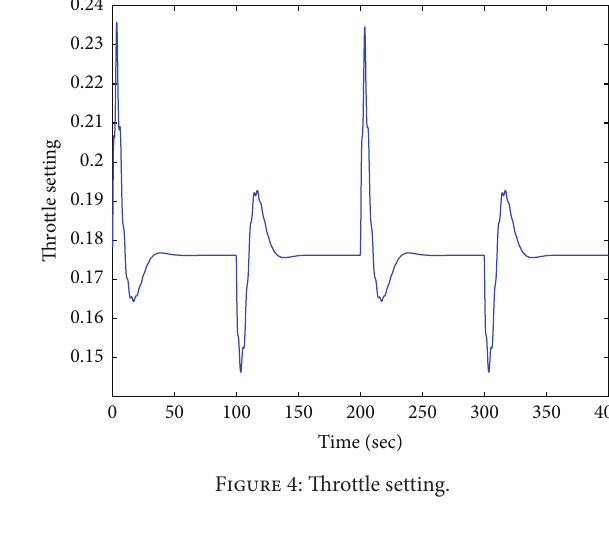
Figure 2: Altitude tracking.